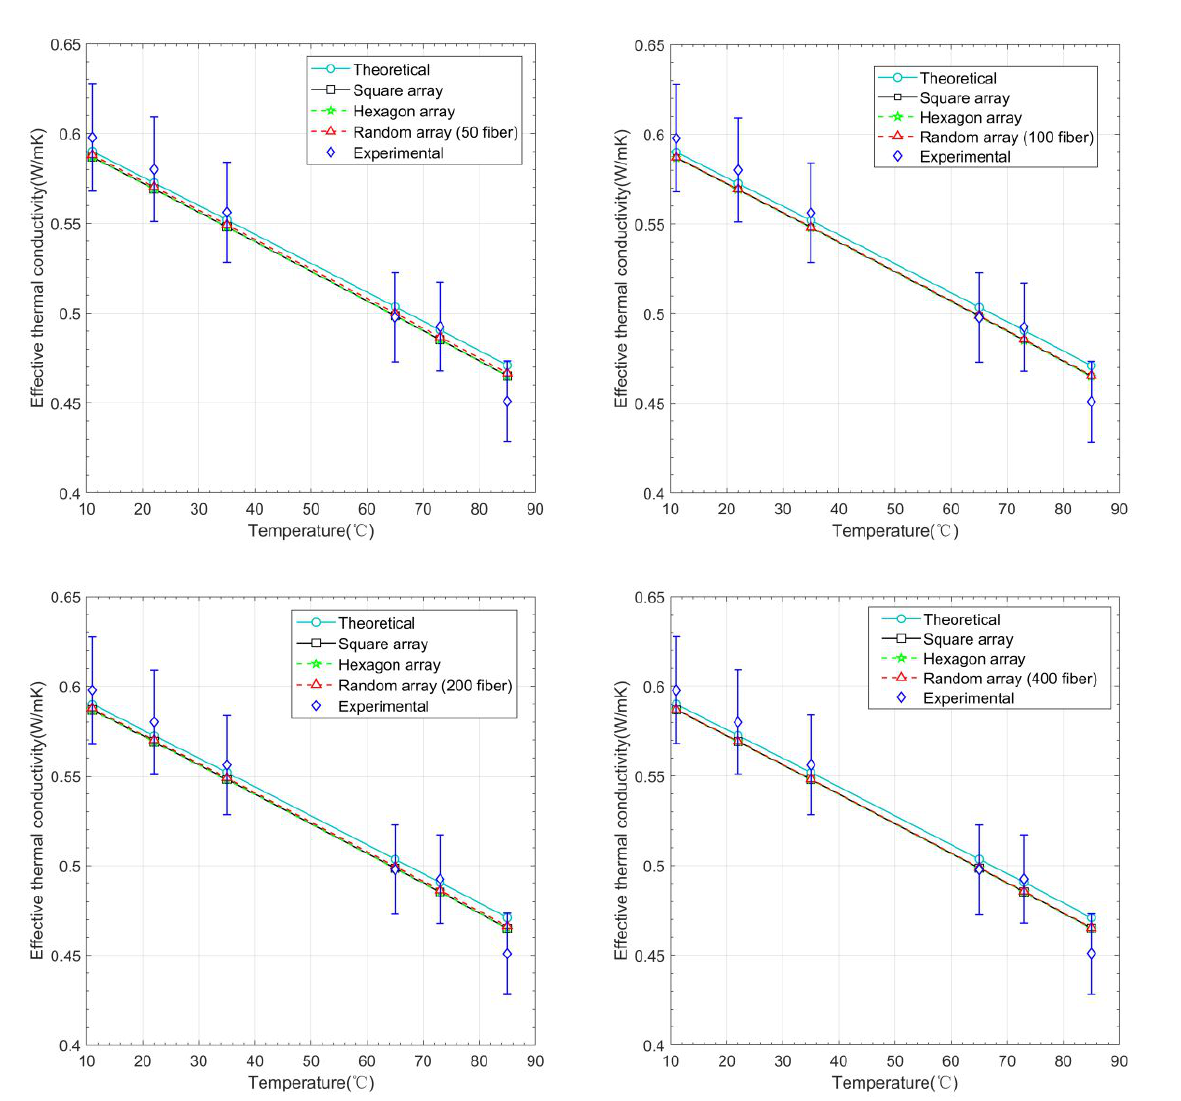
Figure 11: Effective thermal conductivity for different test temperatures with v f = 14%